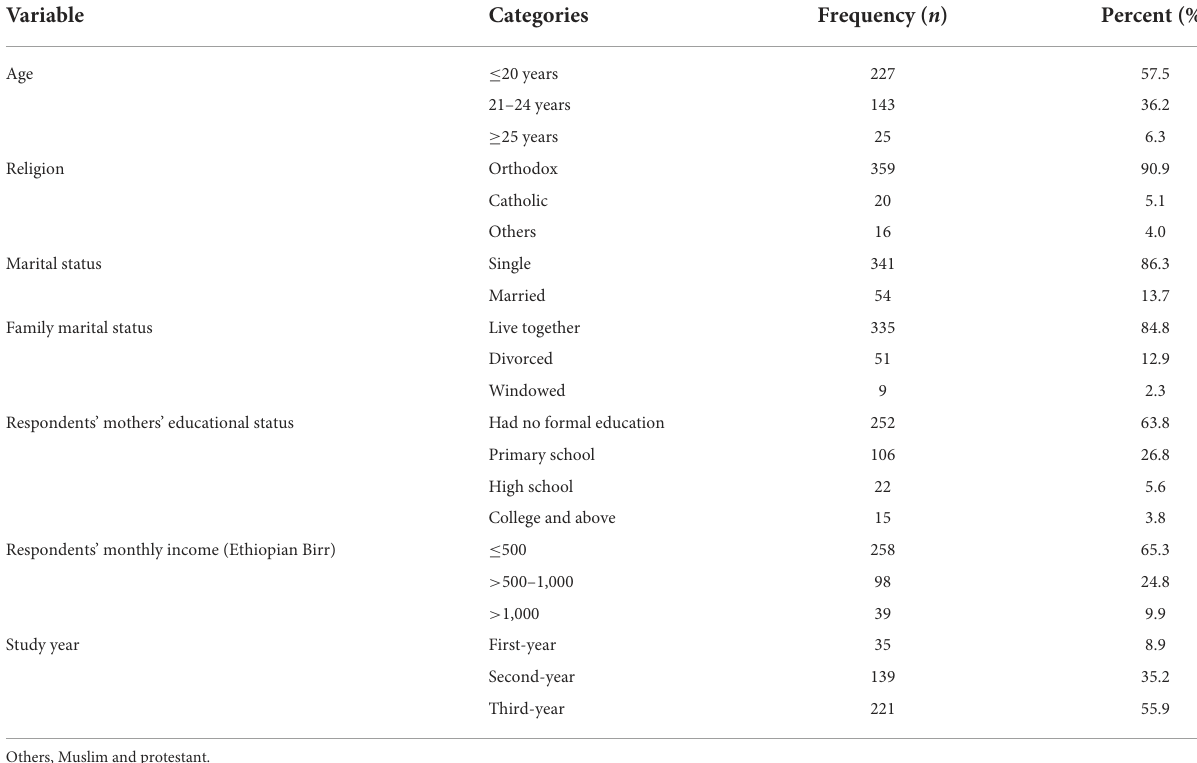
TABLE 1 Socio-demographic characteristics of female college students, Debre Berhan, Ethiopia 2021 ( n = 395). Variable